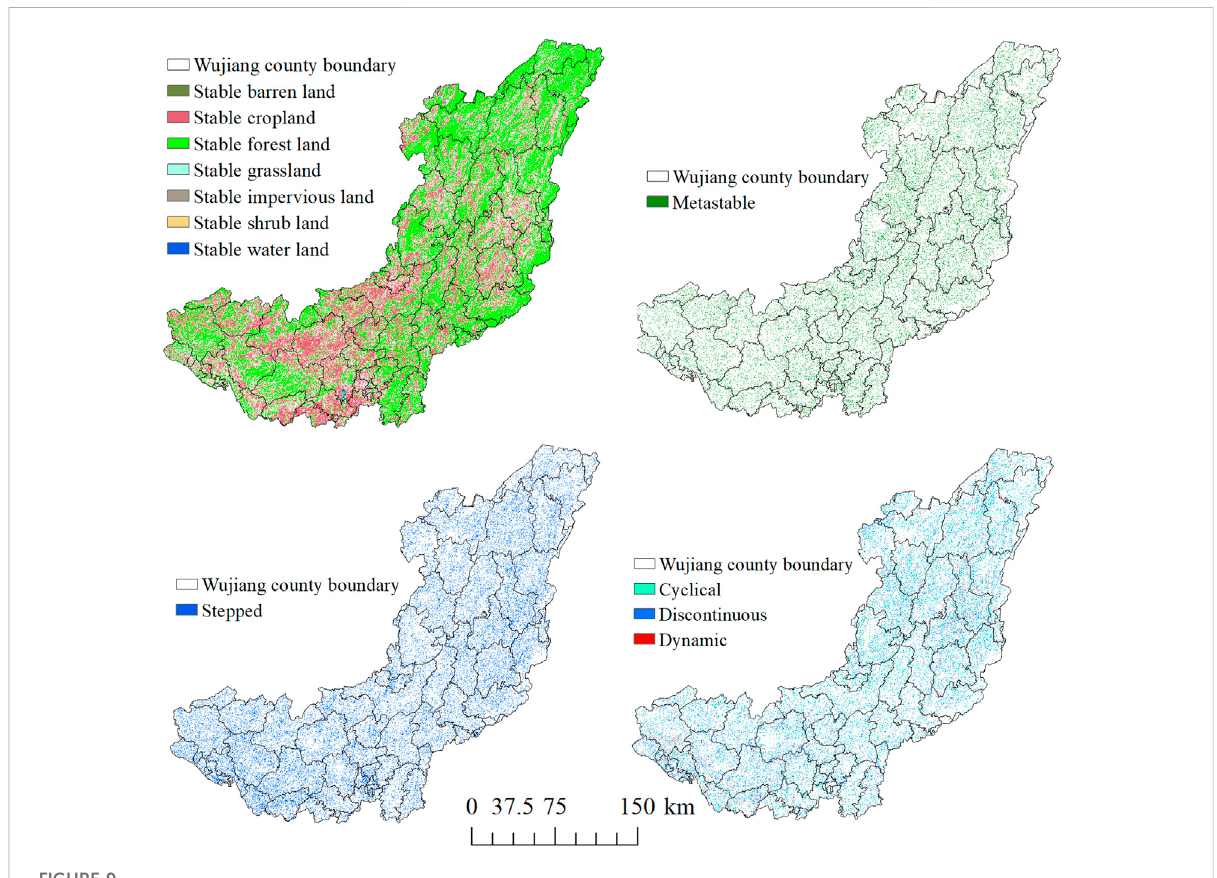
FIGURE 9 The land use change trajectory from 1985 to